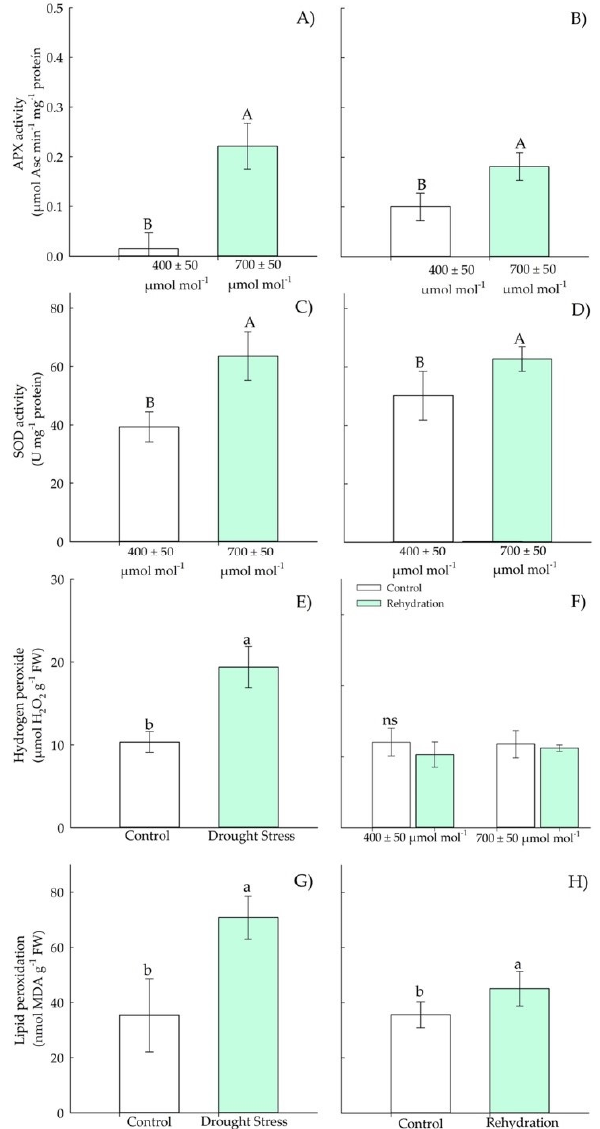
Figure 4. Effects of CO 2 concentration ( a [CO 2 ] = 400 µ mol mol − 1 and e [CO 2 ] = 700 µ mol mol − 1 ) and drought stress in A. buniifolius leaf APX activity ( A , B ), SOD activity ( C , D ), hydrogen peroxide ( E , F ), lipid peroxidation ( G , H ). In plants sampled after drought stress ( A , C , E , G ) and rehydration ( B , D , F , H ) period. Different uppercase letters indicate a significant difference between values in different CO 2 within the same water treatment, while different lowercase letters indicate significant differences between values of different water treatments within each CO 2 level by Tukey’s test ( p ≤ 0.05). ns denotes non-significance ( p > 0.05). Error bars represent a 95% confidence